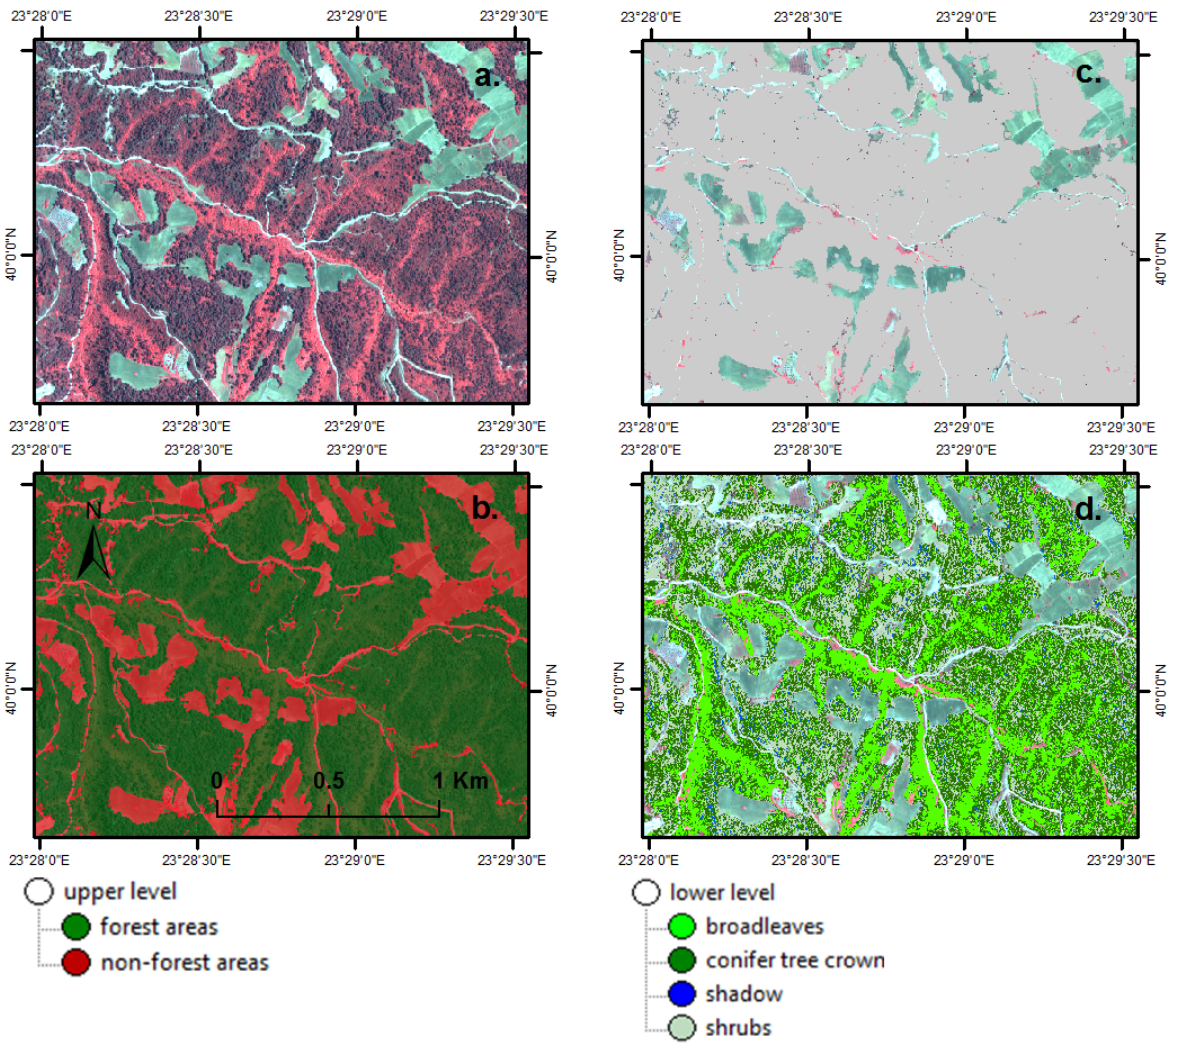
Figure 4. Segmentation (upper panel) and classification (lower panel) results in a subset of the Kassandra study site for upper ( a , b ) and lower ( c , d ) levels of the